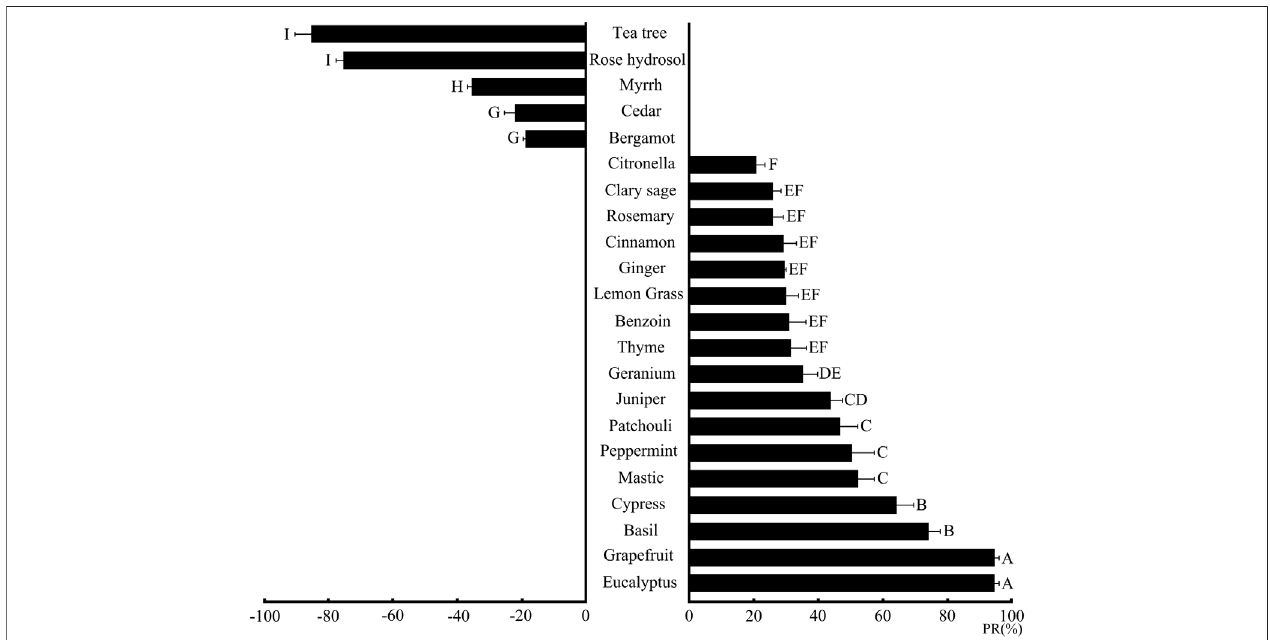
FIGURE 1 | Behavioral response of 22 plant essential oils against L. serricorne adults. Different uppercase letters represented in the fi gure indicate a signi fi cant difference through LSD among different plant essential oils against L. serricorne adults. PR (%), repellent rate (Mean ± SE).